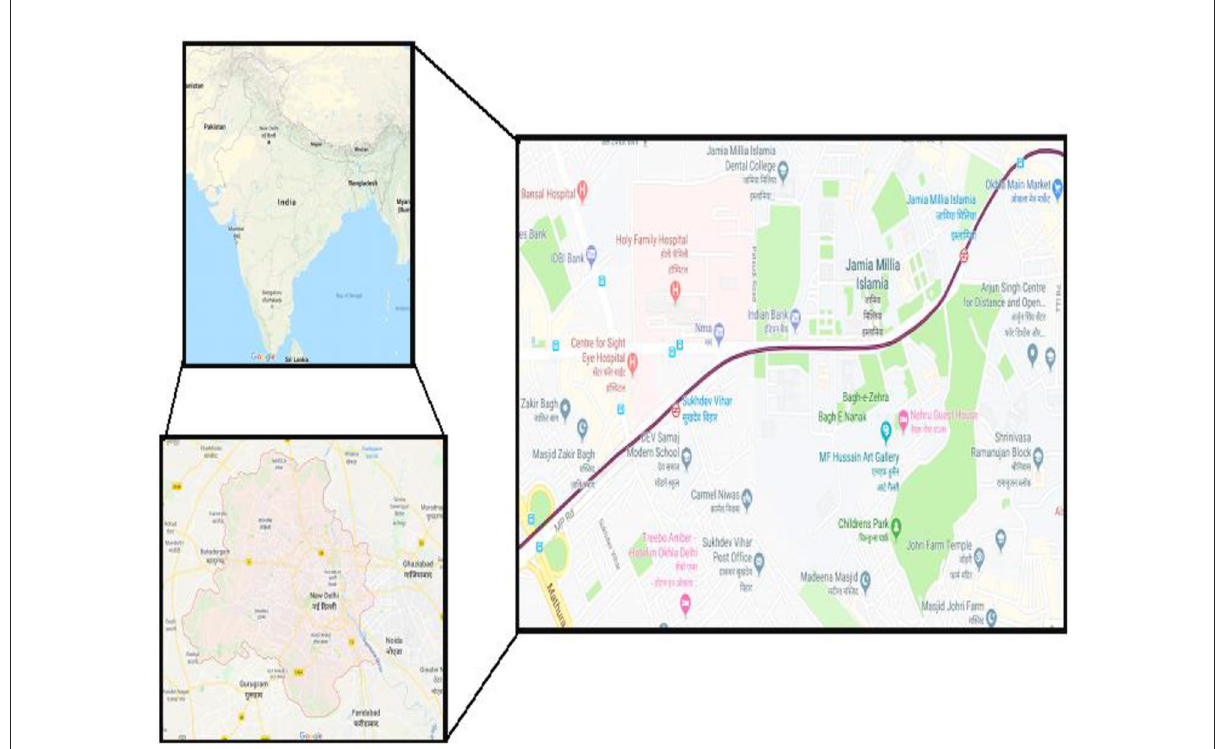
FIGURE4 Geographical location of silent area, New Delhi (Source: https://www.google.com/maps/place/Jamia$+$Millia$+$Islamia/@28.5623169,77.